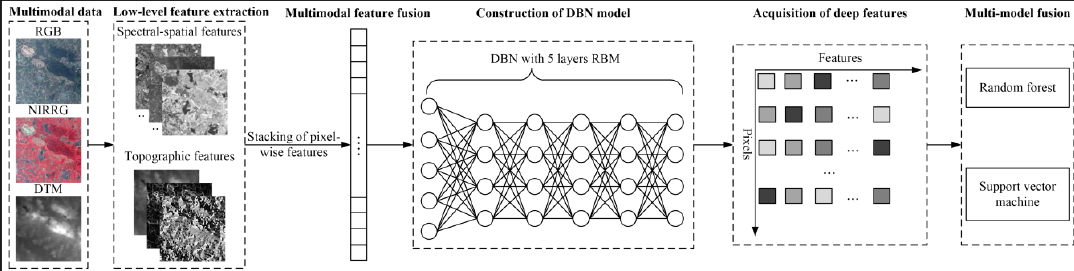
Figure 4. The framework of multimodal and multi-model deep fusion strategy. RGB: ZiYuan-3 true color image with red, green, and blue bands. NIRRG: ZiYuan-3 false color image with near-infrared, red, and green bands. DTM: digital terrain model. DBN: deep belief network. RBM: restricted Boltzmann machine.